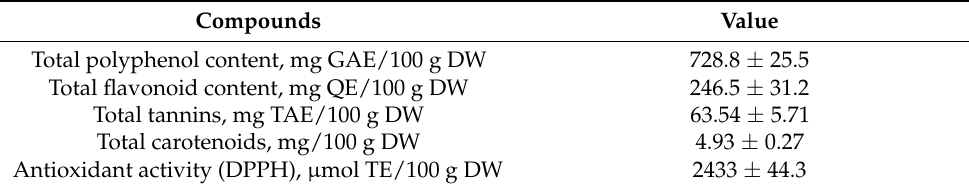
Table 3. Content of biologically active compounds and antioxidant activity in apple pomace powder. Compounds Value Total polyphenol content, mg GAE/100 g DW Total flavonoid content, mg QE/100 g DW Total tannins, mg TAE/100 g